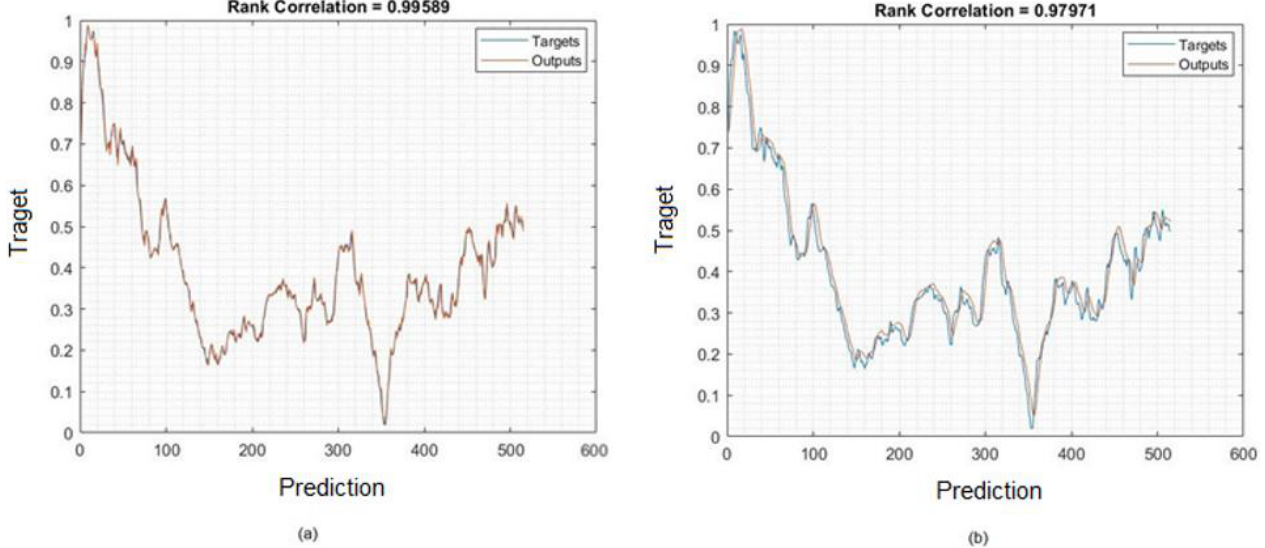
Figure 6. Rank correlation of the deep learning models ( a ) CNN-LSTM and ( b ) LSTM for predicting the Tesla stock market closing price during the training phase.